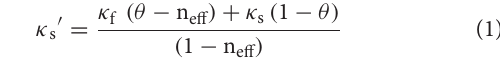
14 numerical grid sublayers (each 0.5 m thick), allowing a